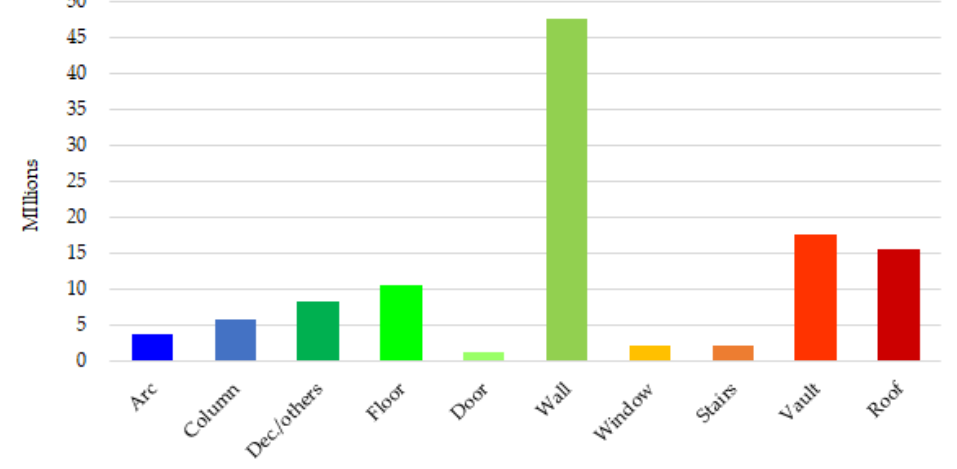
Figure 8. Number of points per class.